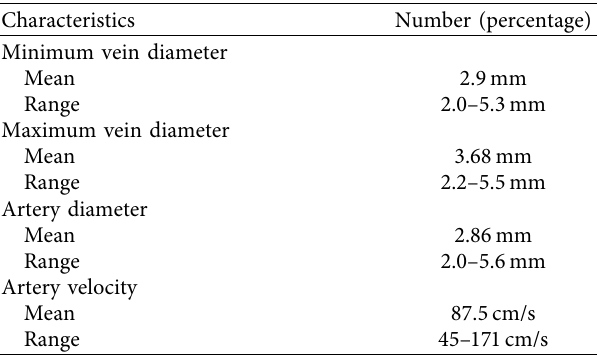
Table 2: Preoperative artery and vein measurements obtained via duplex ultrasound of ipsilateral limb.